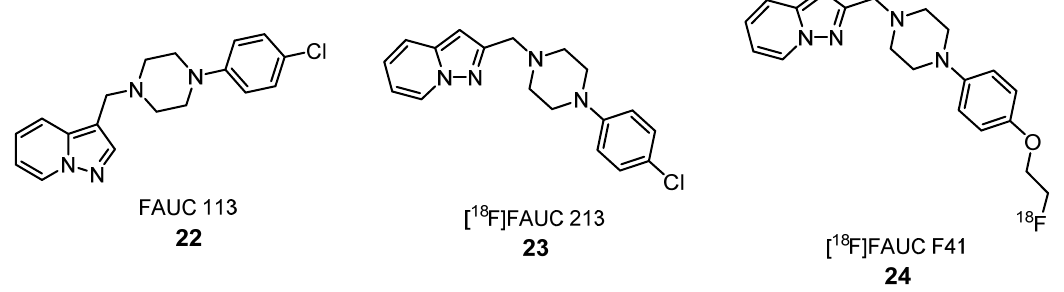
Figure 9. [ 18 F] ‐ labeled high ‐ affinity dopamine receptor (D 4 R) tracers 22 – 24 [52].